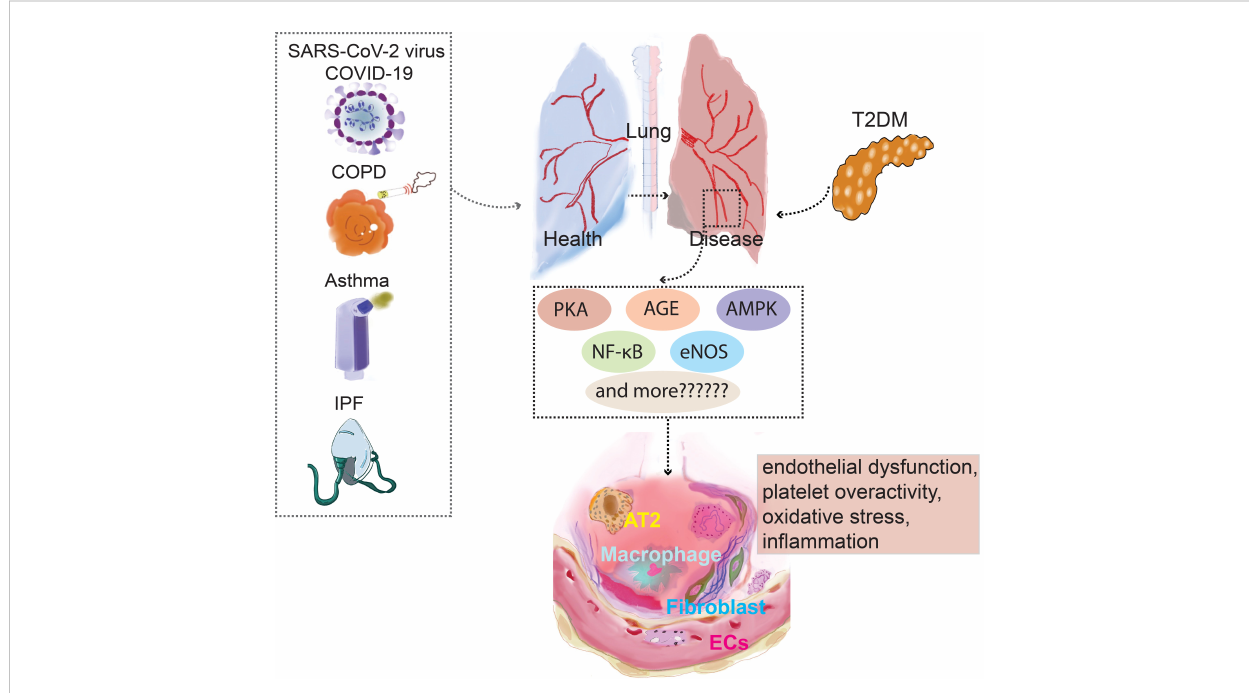
FIGURE 1 PKA,AGE,AMPK , NF- k B ,eNOS are presented as an example for a list of prospective therapeutic targets that diabetes and pulmonary diseases potentially explore through vascular endothelial cells. NF- k B, Nuclear factor kappa B; AT2, Alveolar Type II Cells; COPD, Chronic obstructive pulmonary disease; PKC , Protein kinase C; COVID-19, Coronavirus disease 2019; eNOS, Endothelial NO synthase; AMPK , AMP-activated protein